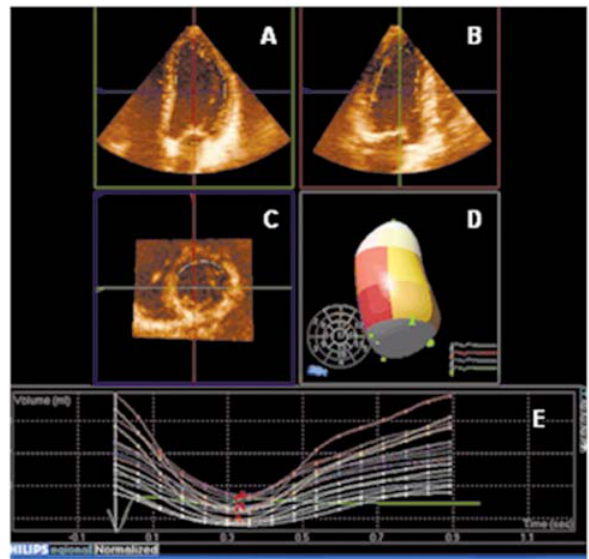
Fig. 3. Delineamento do endocárdico ventricular no processo de análise dos volumes sistólico e diastólico. Podemos observar os três planos tridimensionais básicos: médio-lateral (A), de elevação ou de profundidade (B) e ínfero-superior (C). Além disso, podemos observar a divisão segmentar do ventrículo esquerdo (D) e o